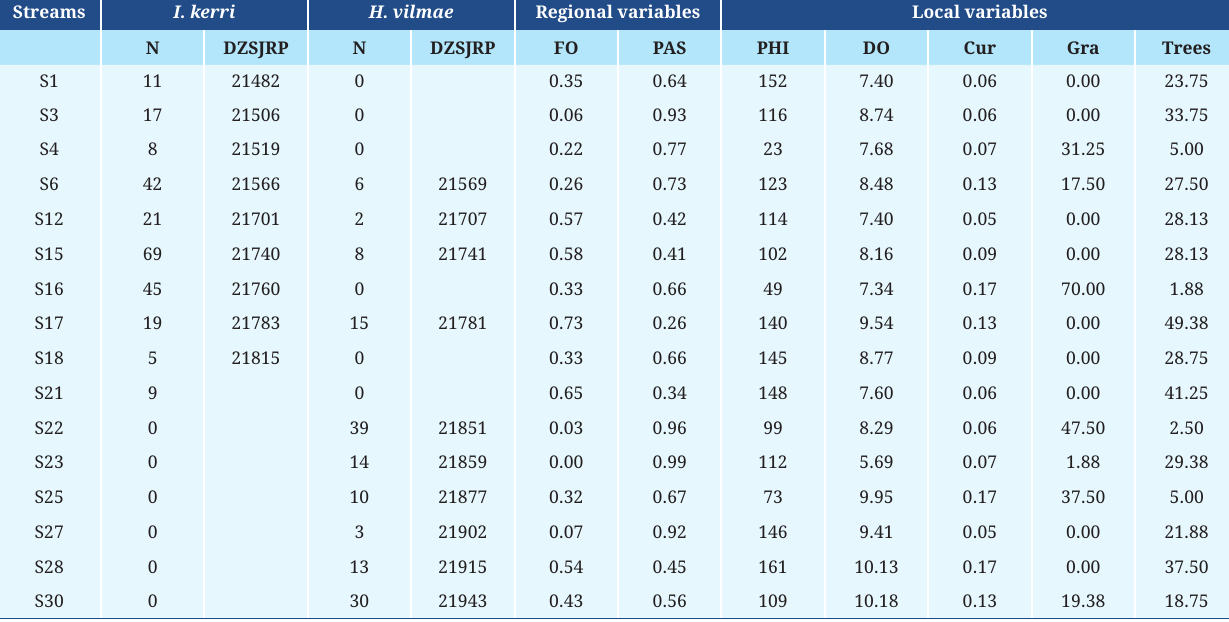
TABLE 1 | Abundance (N) and voucher number in the DZSJRP collection of Inpaichthys kerri and Hyphessobrycon vilmae , regional and local environmental variables in the sampled streams. FO = proportion of forest in the watershed; PAS = proportion of pasture in the watershed; PHI = physical habitat index; DO = dissolved oxygen (mg/l); Cur = water current (m/s); Gra = % of marginal grasses in the banks; Trees = % of the riparian buffer covered by